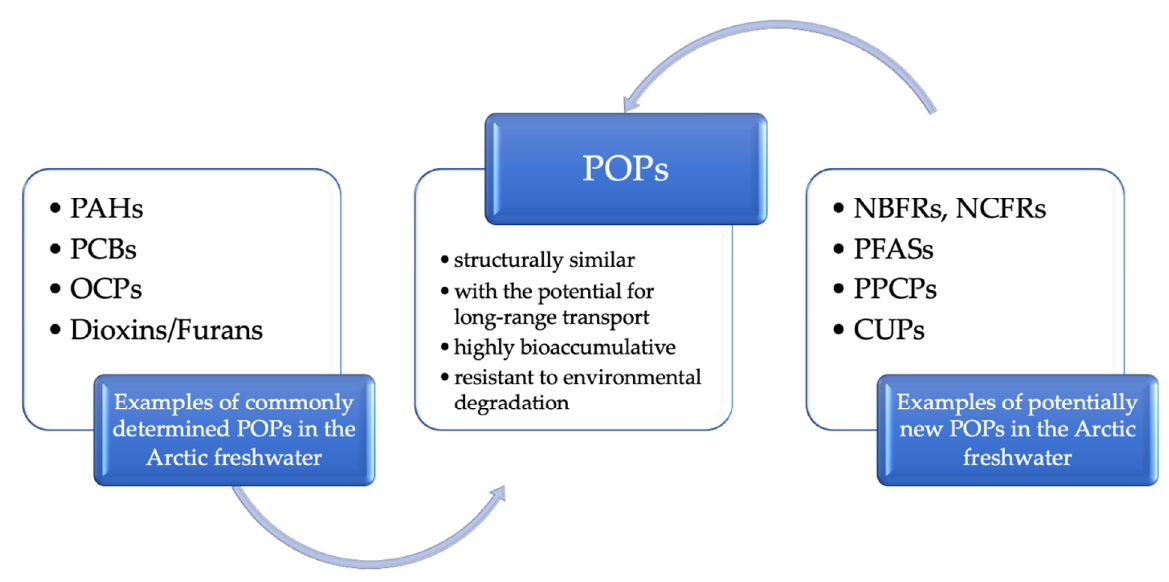
Figure 2. Examples of a wide variety of pollutants that may be considered as POPs.